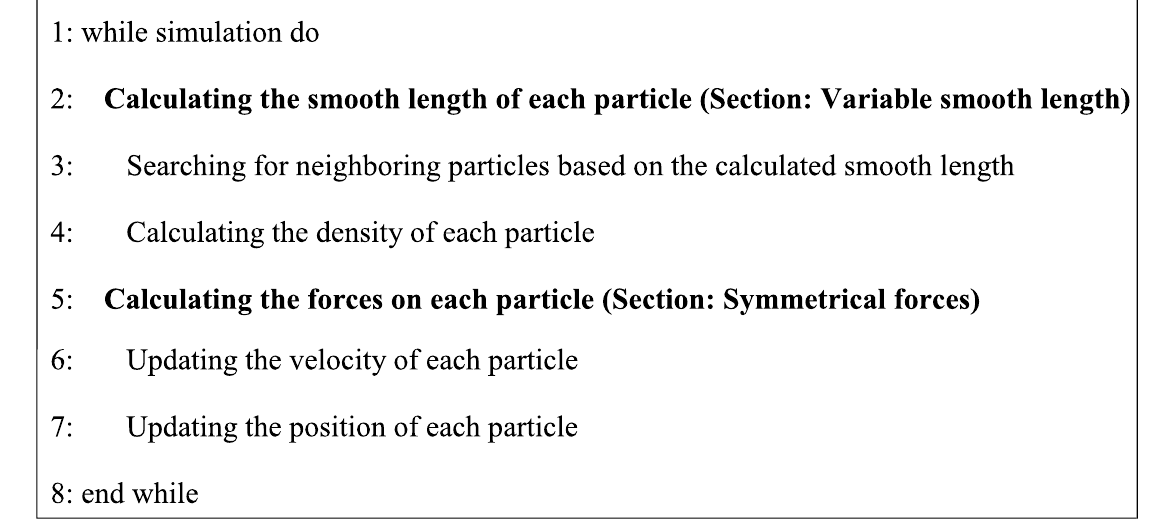
Algorithm 2 Overview of our method